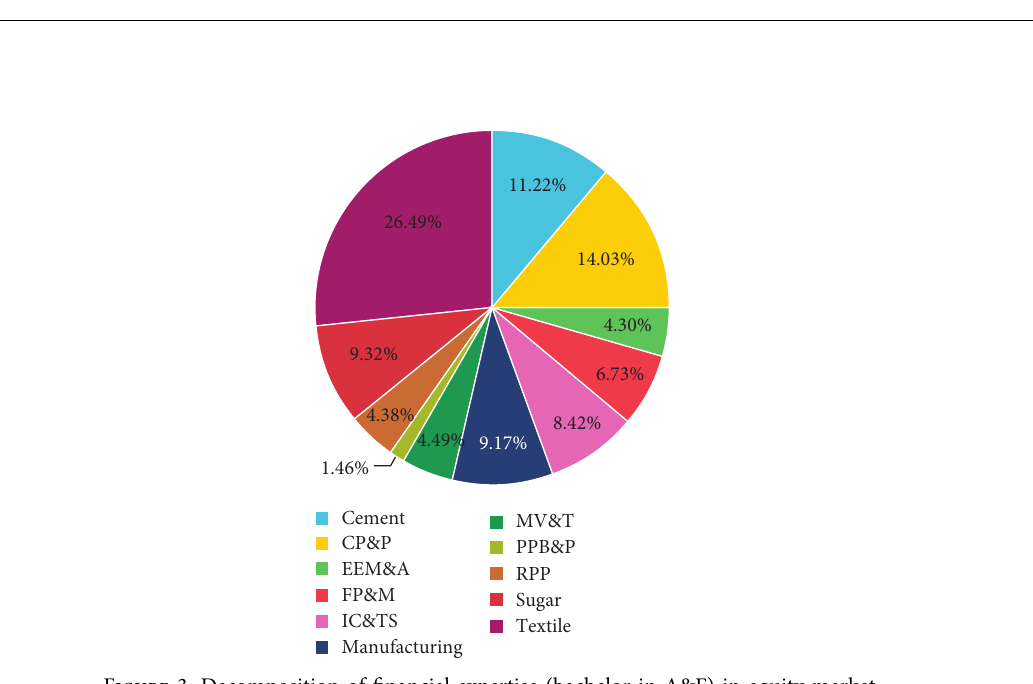
Figure 3: Decomposition of financial expertise (bachelor in A&F) in equity